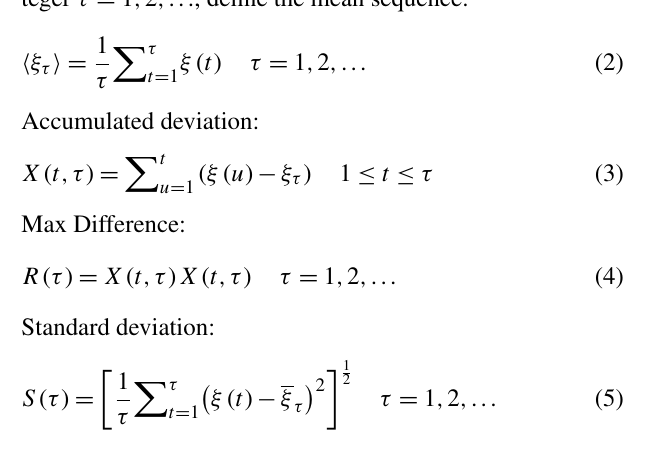
the correlation between the first variable and the third vari- able; r 23 is the correlation between the second variable and the third variable; the closer r 12 − 3 to 1, the higher the partial correlation